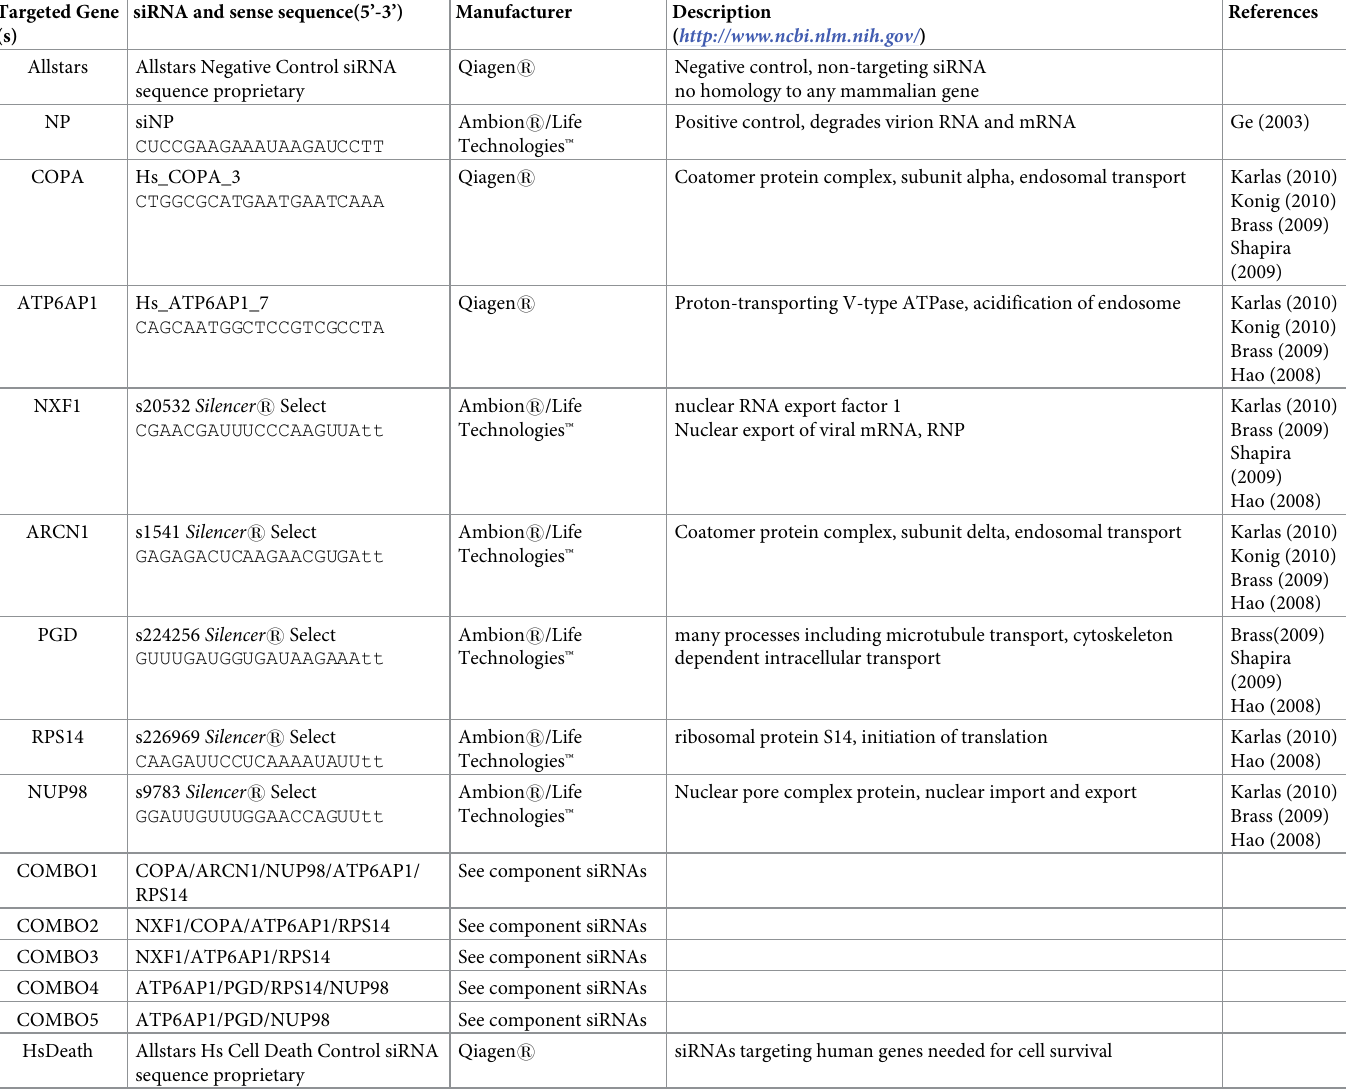
Table 2. Name and characterization of siRNAs